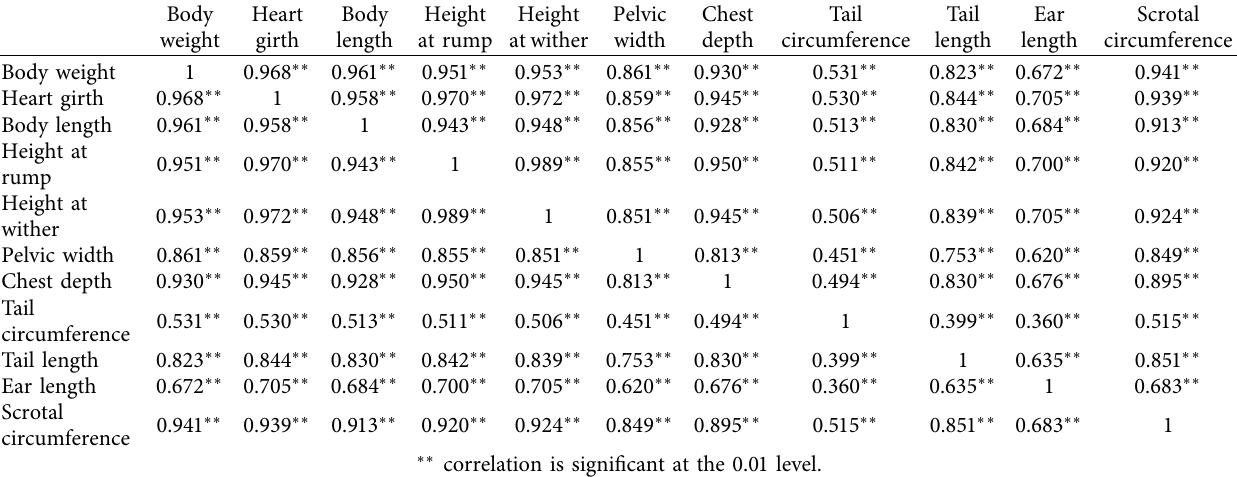
Table 3: Correlations between linear body measurements in Blackhead Somali sheep.